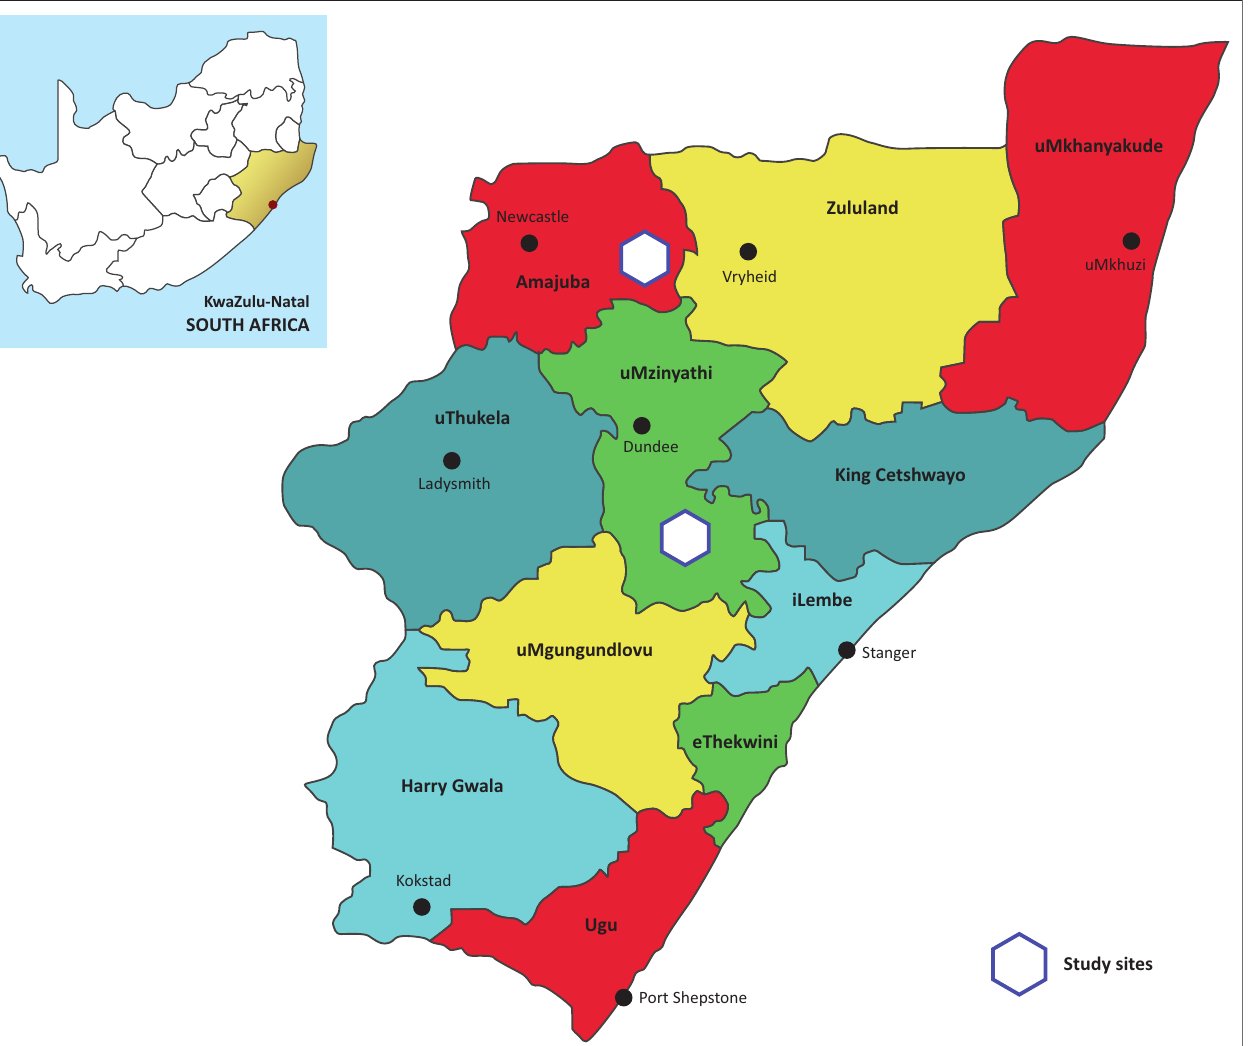
FIGURE 1: Map of KwaZulu-Natal district municipalities showing study